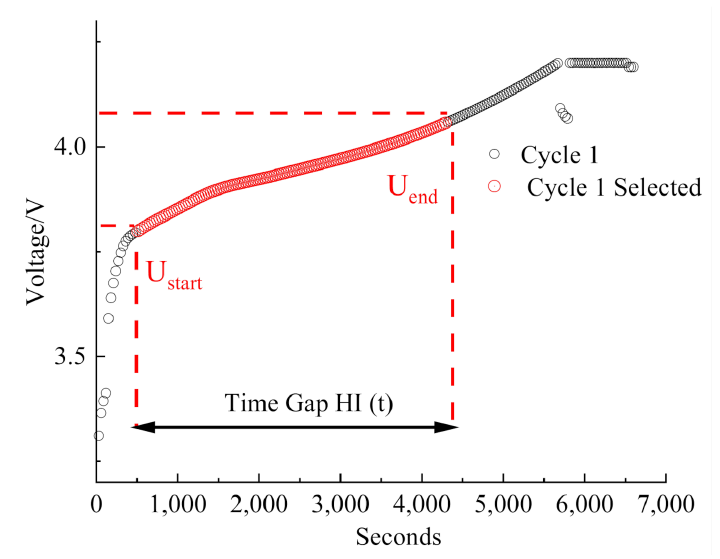
Figure 2. Health factor